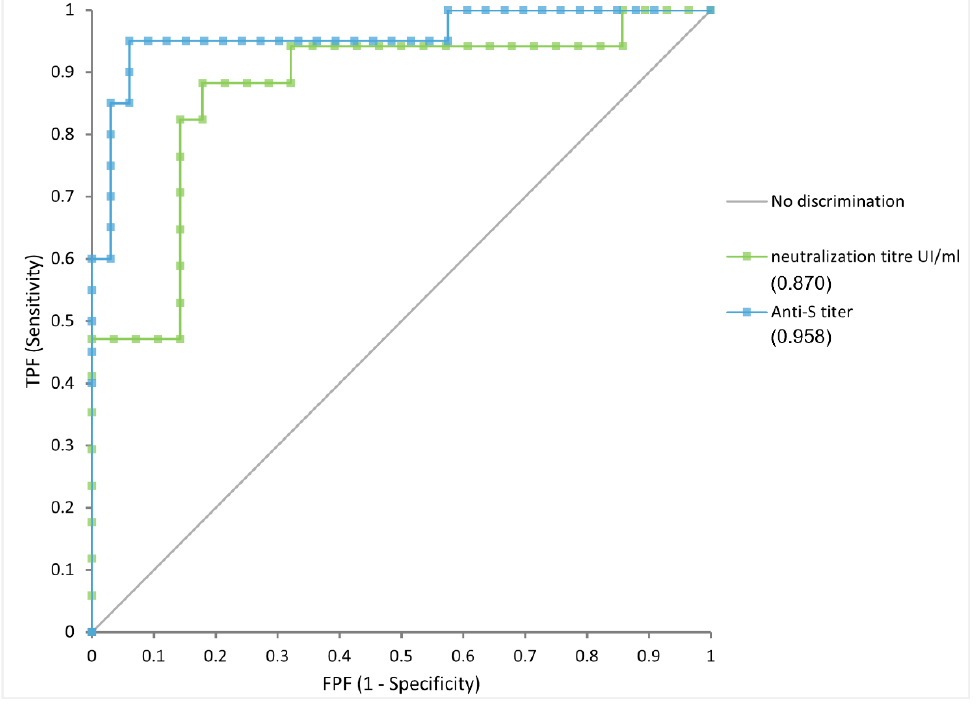
Table 1. Comparison between sVNT and anti-S eCLIA titers in different HCW populations.